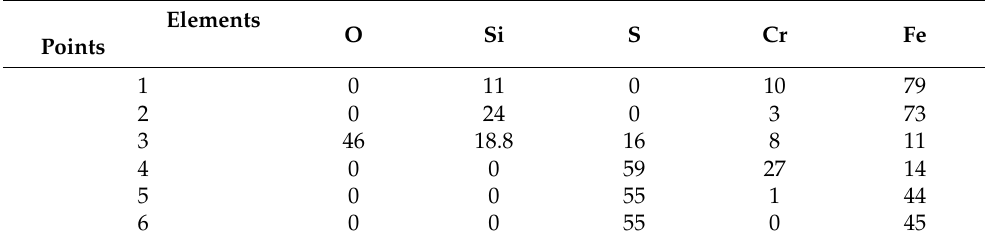
Figure 9. Cross-sectional image: ( a ) low-magnification, ( b ) high-magnification and ( c ) XRD spectrum of Fe-10Cr-10Si alloy corroded in H 2 -CO 2 -H 2 S mixture at 600 °C for 24 h. Table 3. Chemical composition (at.%) (by EDS) of different parts of the scales formed on Fe-10Cr-10Si corroded in H 2 -CO 2 -H 2 S mixture at 600 °C for 24 h.